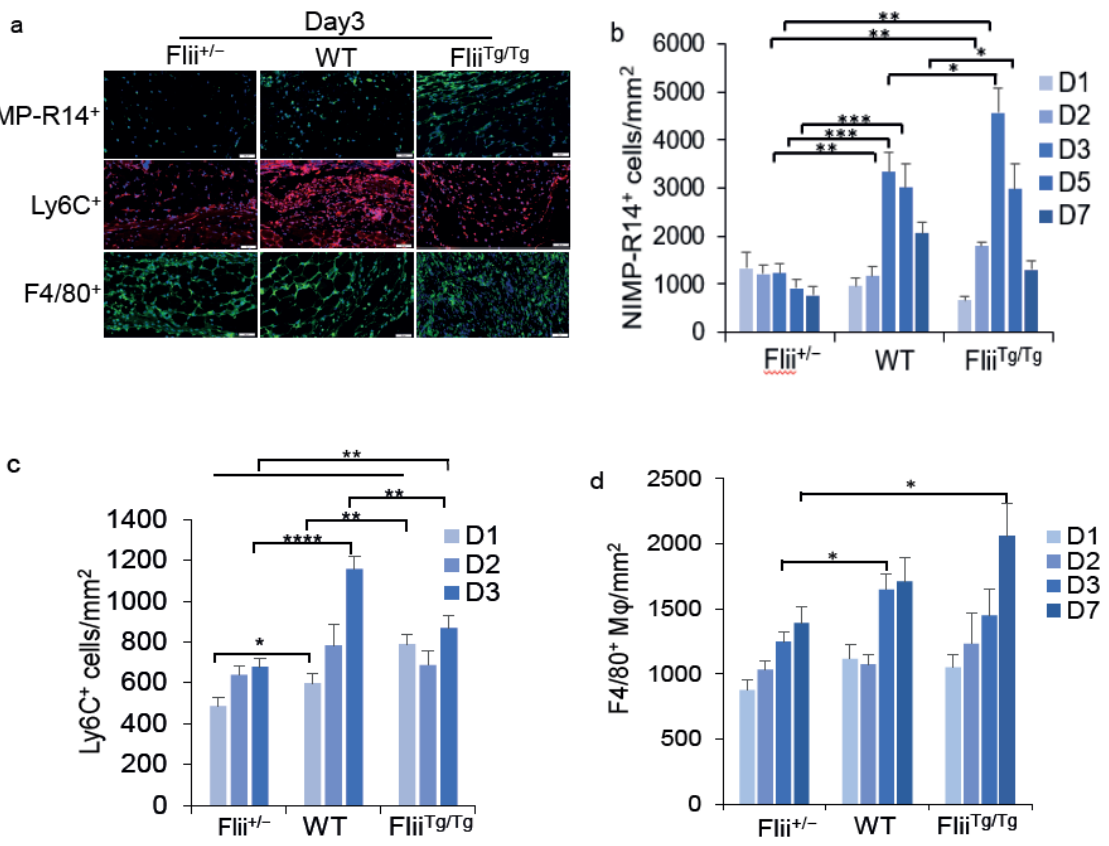
Figure 2. Wound neutrophils, monocytes, and macrophages for the Flii genotypes (Flii +/ − , WT, and Flii Tg/Tg ): ( a ) Representative images of neutrophil (NIMP-R14), monocyte (Ly6C), and macrophage (F4/80) staining in wounds from the 3 Flii genotypes at day 3; Bar graphs showing ( b ) neutrophil, ( c ) monocyte, and ( d ) macrophage cell numbers within the wounds of the 3 Flii genotypes ( n = 6). Scale bars = 50 µ m. Results are expressed as mean ± SEM. * p < 0.05, ** p < 0.05, *** p < 0.001 and **** p < 0.0001.